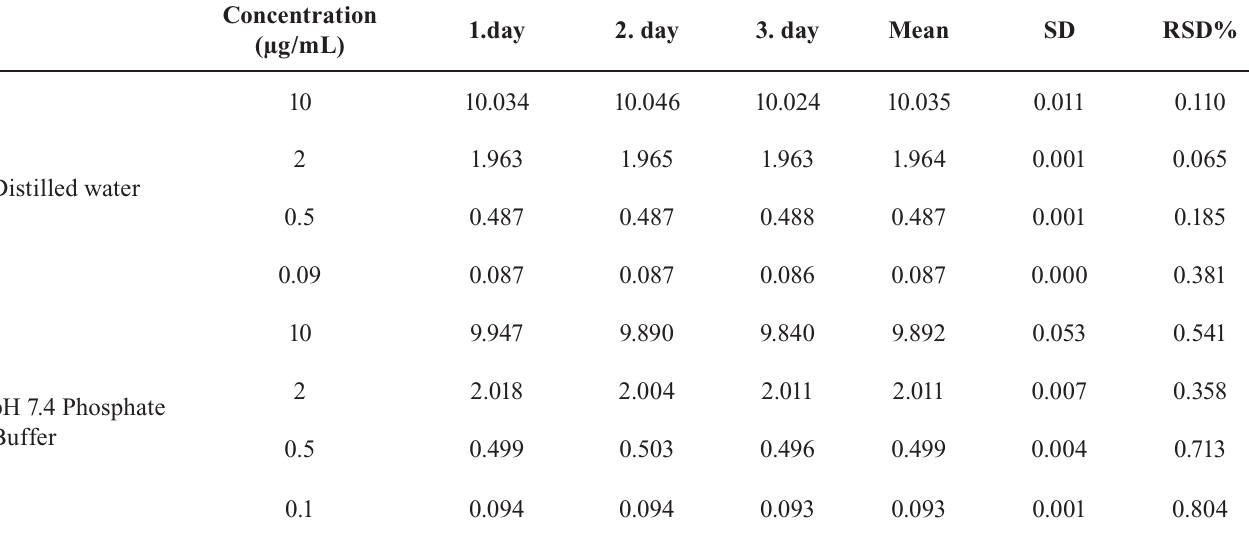
TABLE VI - Inter-day precision for dexketoprofen trometamol